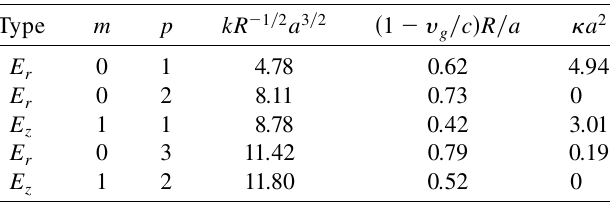
TABLE I. Lowest modes in the toroidal waveguide of the square cross section. The wave number of the mode k , the difference between c and the group velocity, 1 (cid:5) v the loss factory + are all normalized by the proper combina- tions of R and a .